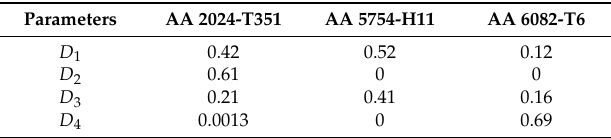
Table 3. Bai–Wierzbicki parameters of aluminum alloys.